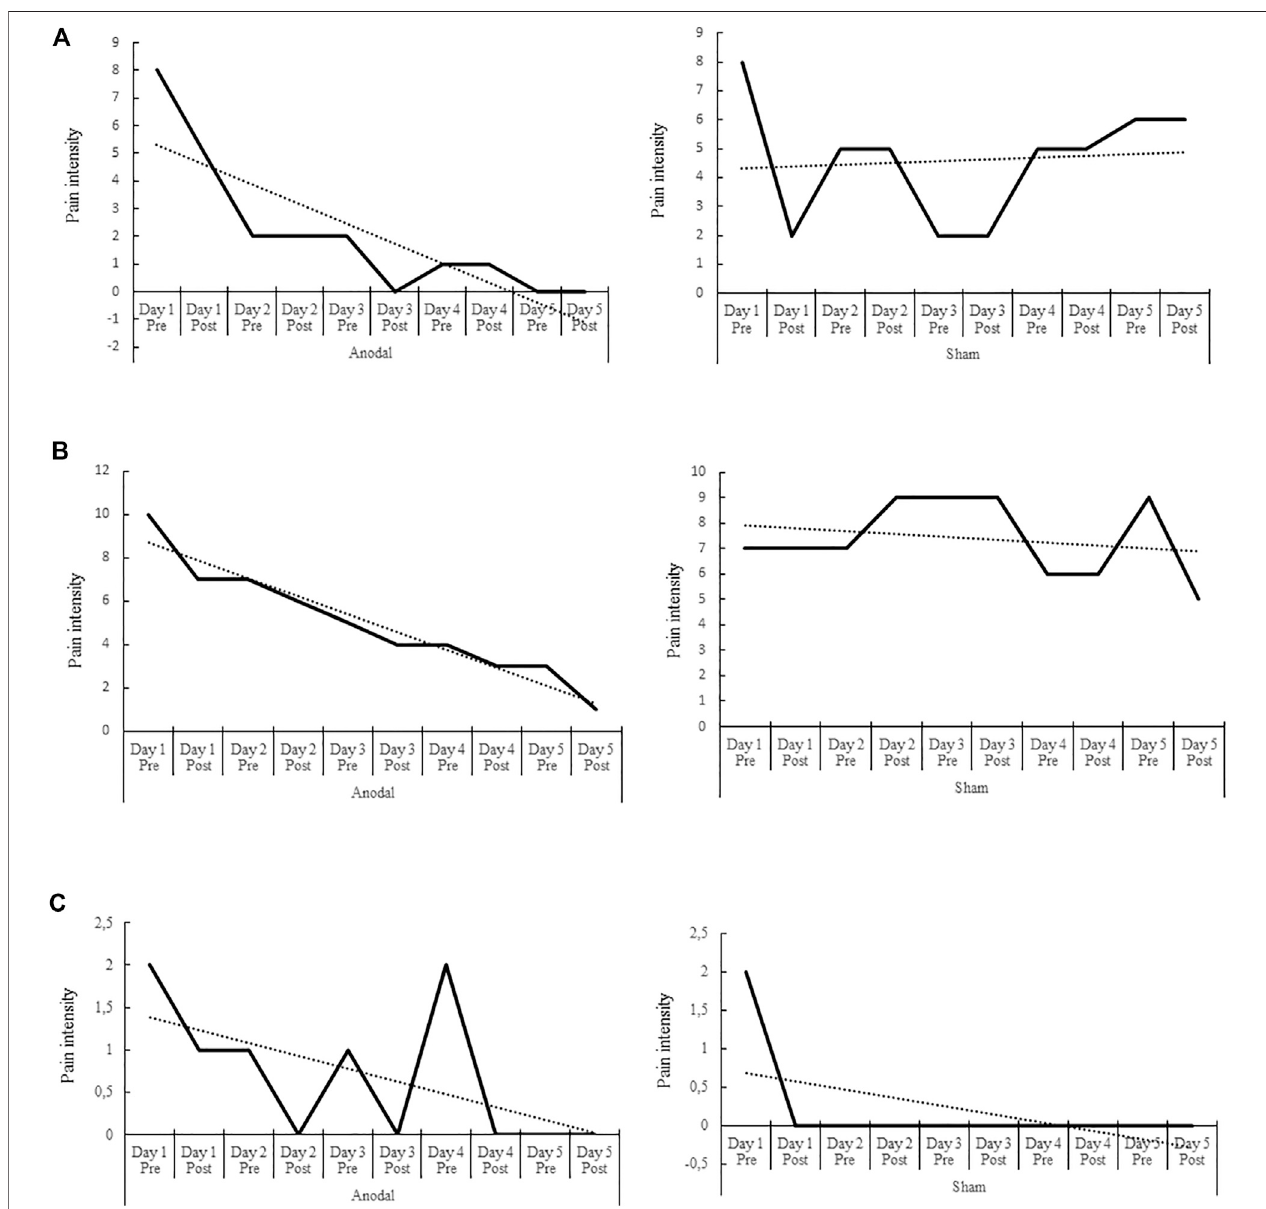
FIGURE2| Pre-andpost-anodalandshamtDCSvaluesofpainintensityoftheAdaptiveVisualAnalogScalesofpainintensityandimprovement(AVAS)foreachof the three patients (A – C) throughout the fi ve intervention sessions (day 1 – 5). The dotted lineindicates the data trend. Signi fi cant differences between pain intensity mean valuesoftheanodalandshamtDCSconditionswerefoundineachpatient( p (cid:2) 0.005, p (cid:2) 0.007, p (cid:2) 0.028,respectively),withreducedpainintensityvaluesafteranodal tDCS in patients 1 and 2.